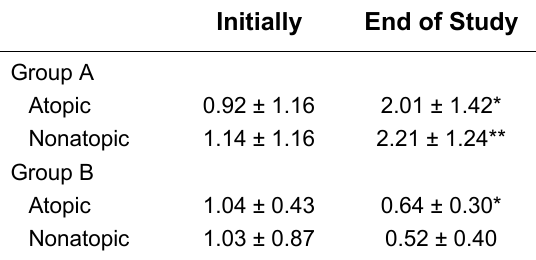
PD , Initially and at the End of the Study when 20 Compared to the Atopic Status Initially